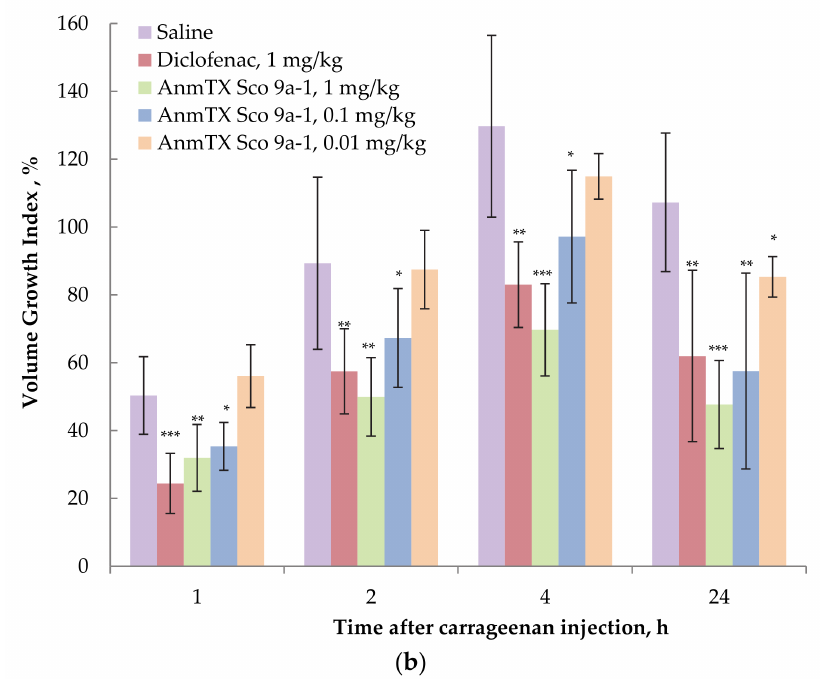
Figure 4. Time dependent effect of AnmTX Sco 9a-1 on ( a ) paw volume and ( b ) Volume Growth Index (%) in the carrageenan-induced inflammation model. A saline buffer as a negative control and Diclofenac at a dose of 1 mg/kg administered intramuscularly as a positive control were used. Results are presented as mean ± SD (n = 7–8). The significance was calculated by the Student’s t -criterion to the saline group and was marked as * p < 0.05, ** p < 0.01, and *** p < 0.001.